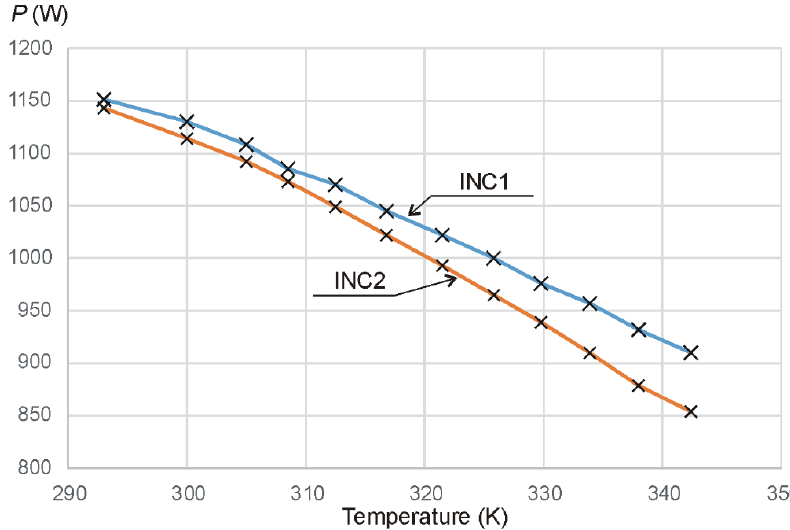
Figure 15. Measured power of the MPPT: INC1—proposed conductance-based method; INC2— incremental conductance method tuned for assumed solar irradiance level versus temperature in K under constant solar irradiance 1000 W/m 2